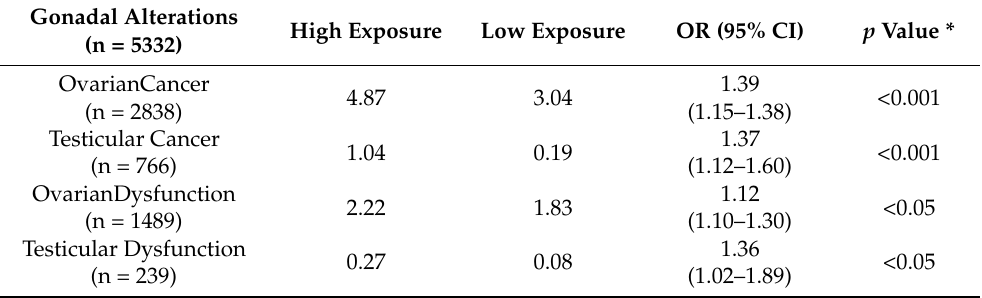
Table 2. Prevalence (rate per 1000 inhabitants), odds ratio (OR), and 95% confidence interval (95% CI) for gonadal diseases in the population living in areas of high pesticide exposure relative to areas of low exposure.